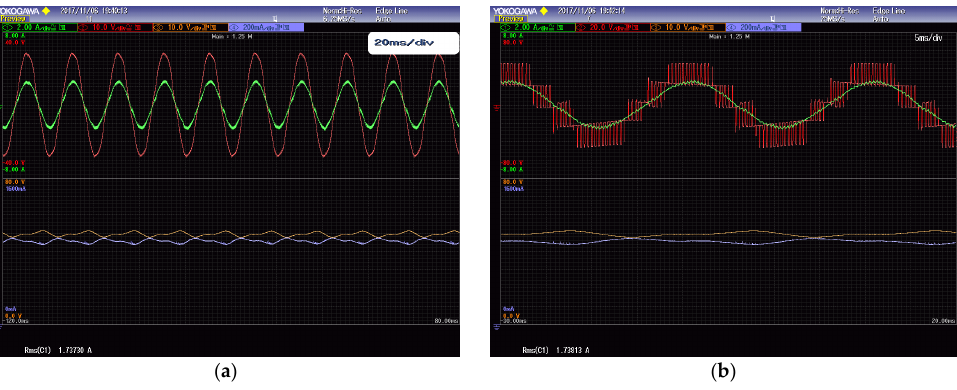
Figure 18. Input/output steady-state waveforms of the converter with V S = 100 V, R S = 60 Ω , V = V MPP = 50 V: ( a ) grid voltage and current (top traces), PV voltage and current (bottom traces); ( b ) time zoom: inverter voltage and current (top traces), PV voltage and current (bottom traces).